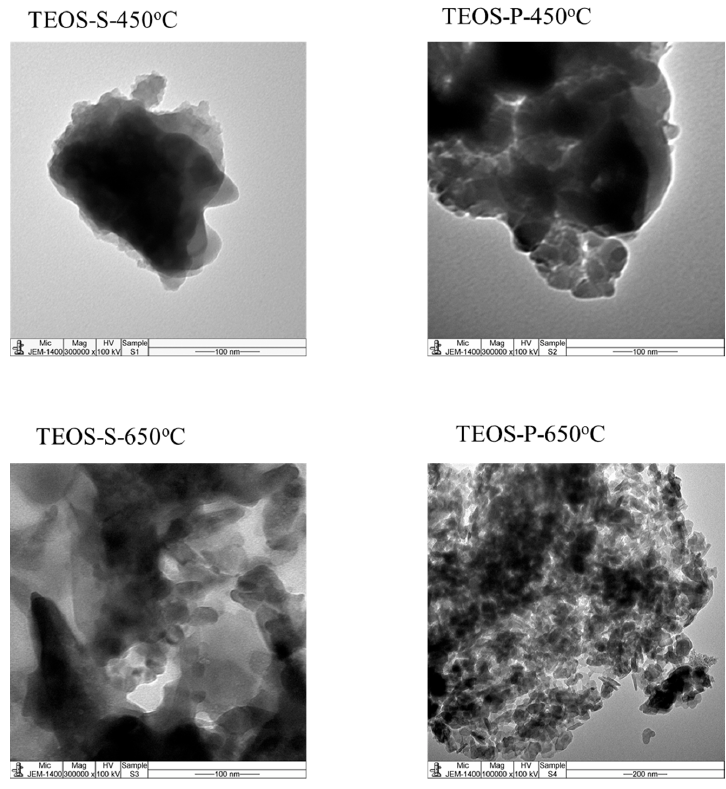
Figure 5. Transmission electron micrographs of silica prepared from TEOS treated with sulfuric and phosphoric acid and calcined at 450 and 650 ◦